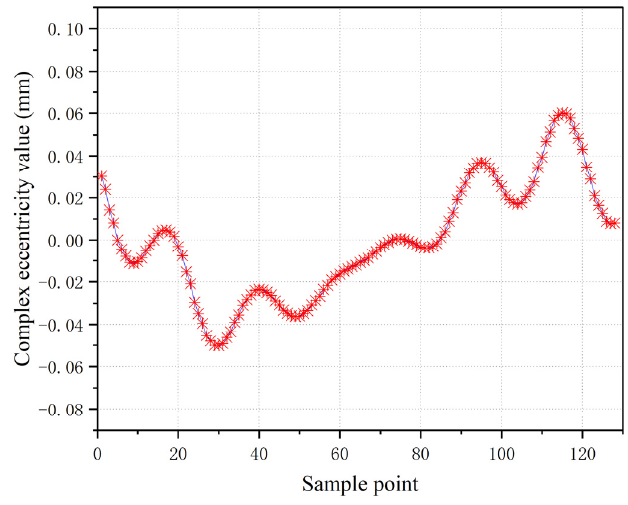
Figure 14. Eccentricity compensation model.